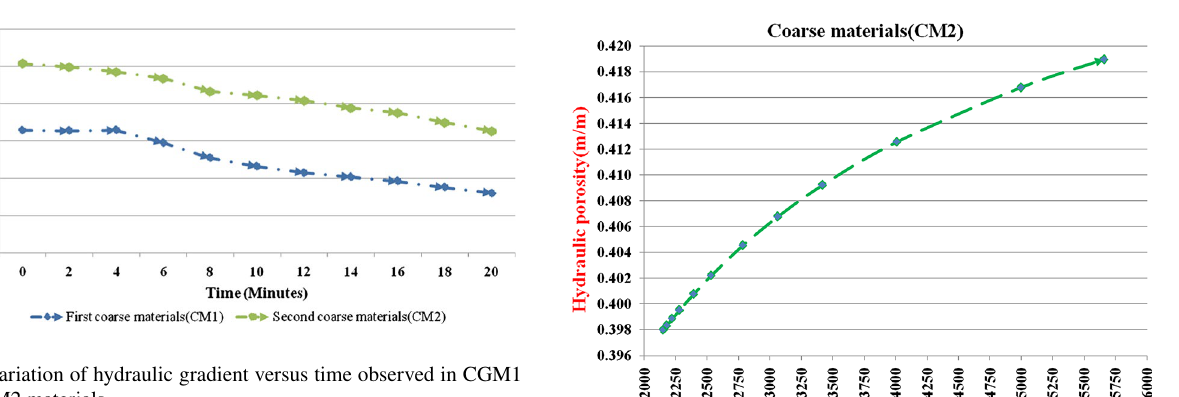
Fig. 4 Variation of hydraulic gradient versus time observed in CGM1 and CGM2 materials